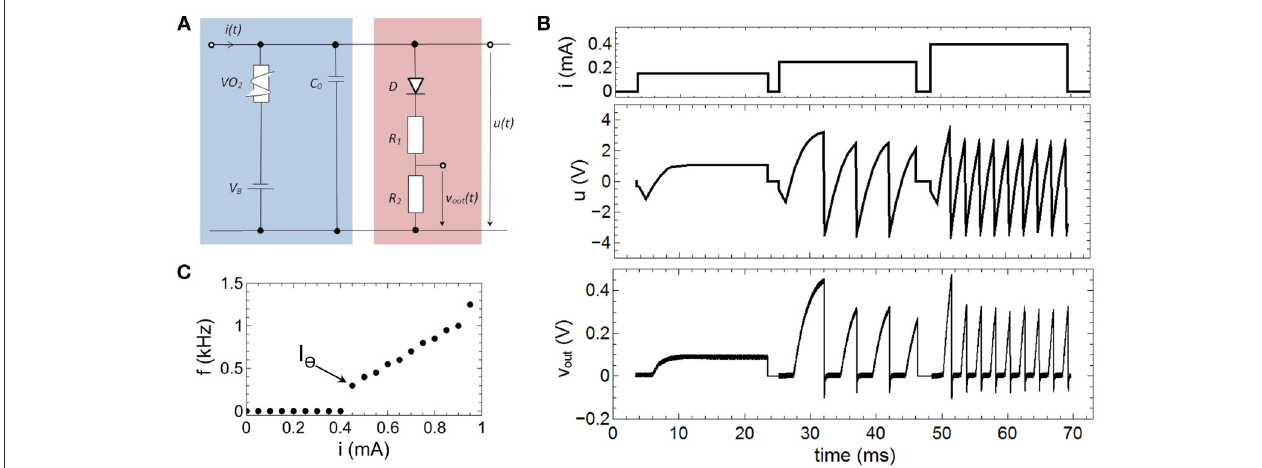
FIGURE 6 | Emulation of fire frequency coding: (A) Circuit layout to emulate firing frequency coding. In contrast to Figure 2 C M was replaced by a constant capacitance C 0 . (B) Recorded spike pattern for different current inputs. (C) Measured oscillation frequencies as function of the input current i(t) . I 2 denotes the threshold value for the spike initiation. Parameters used for the circuit: R 1 = 47 k (cid:127) , R 2 = 10 k (cid:127) , C 0 = 0.068 µ F, V B = −